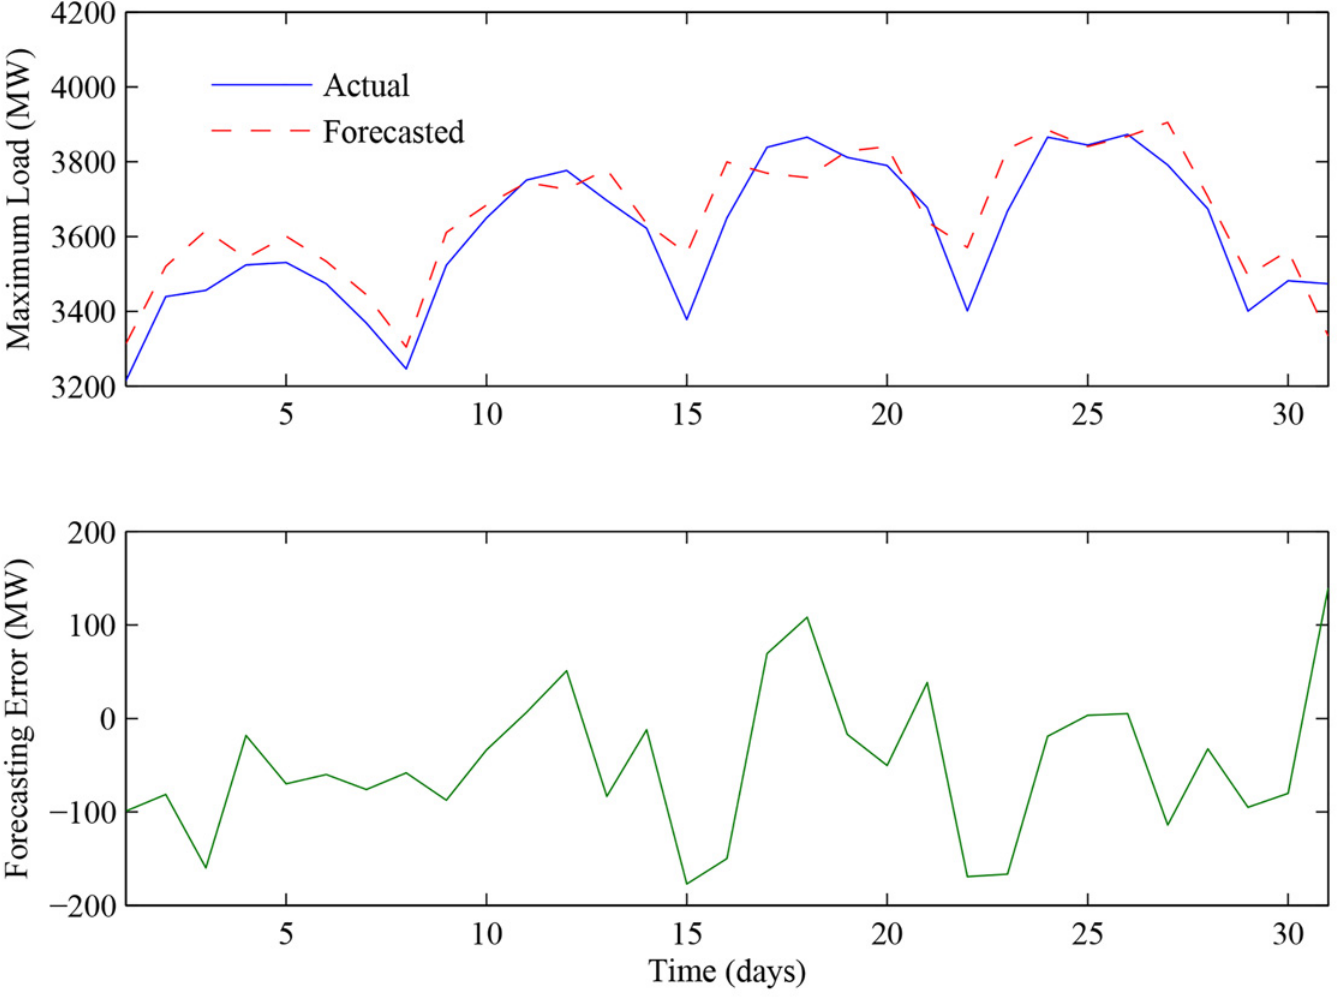
Fig 5. Forecasting results of daily maximum load of December in 2013. The blue solid line represents the forecasting maximum load of December in 2013. The red dotted line represents the actual maximum load of December in 2013. The green line represents the forecasting error between the forecasting values and the actual